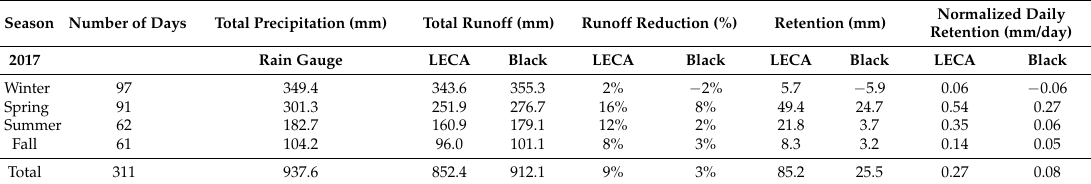
Table 1. Seasonal variation in retention